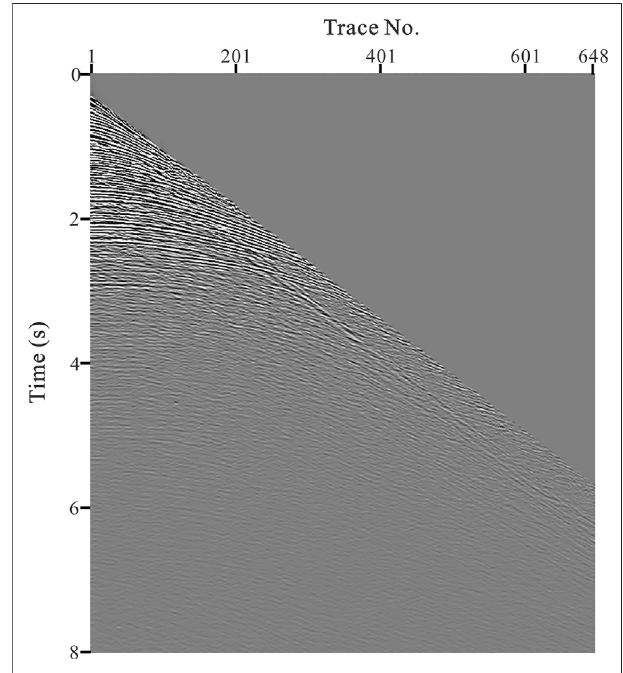
FIGURE 9 | The seismic record of the 601st